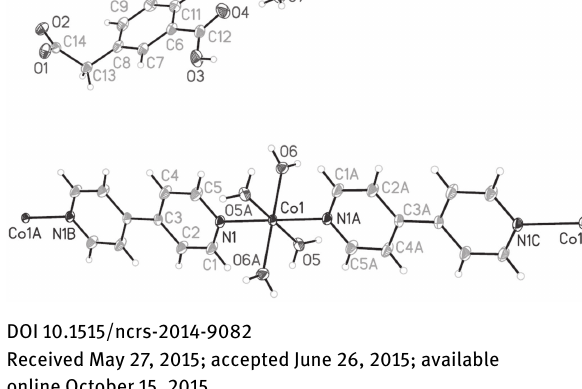
Table 2: Atomic coordinates and displacement parameters (in Å 2